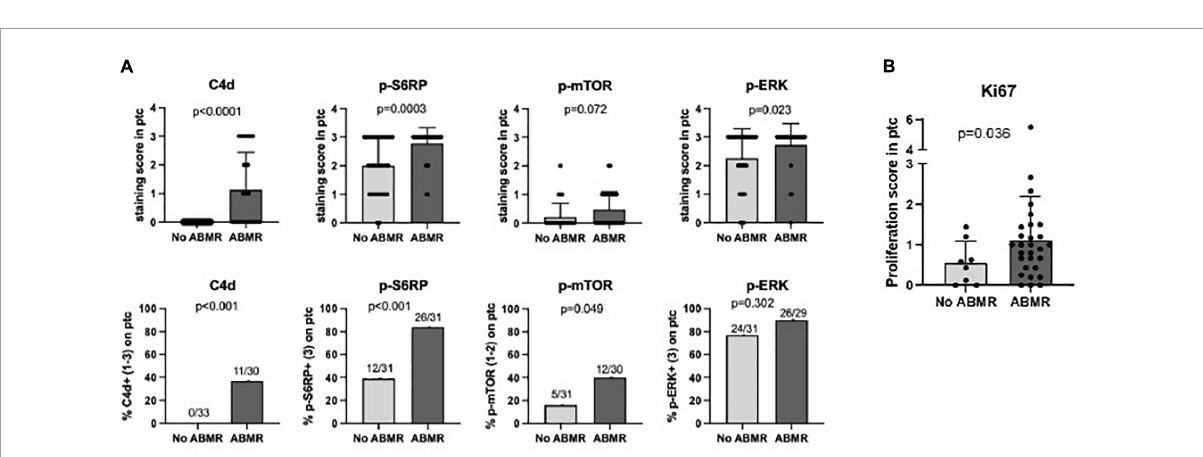
FIGURE2 Staining of p-S6RP in peritubular capillaries is increased in ABMR biopsies. (A) Staining score (upper graphs) and percentage of positive staining (lower graphs) of C4d, p-S6RP, p-ERK, and p-mTOR in PTC of renal allografts biopsies with ABMR + DSA+ ( n = 31) compared to ABMR–DSA– ( n = 33). Mann Whitney and Fisher exact tests were used to assess significant differences between these two groups. (B) Staining of the proliferation marker Ki67 was analyzed in biopsies with and without ABMR. Plots show the means (bars), standard deviation (error bars), and individual values (dots) for each sample. Mann Whitney and Fisher exact tests were used to assess significant differences between